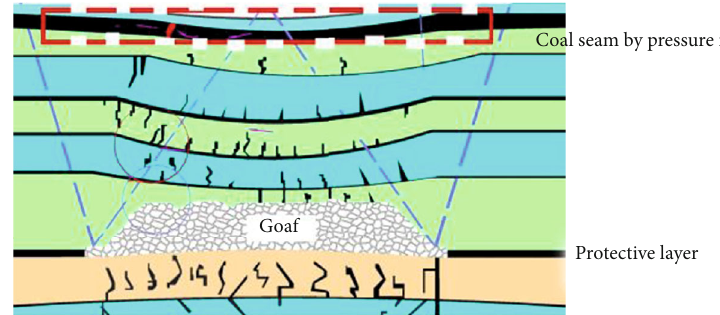
Figure 1: Schematic diagram of mining under pressure